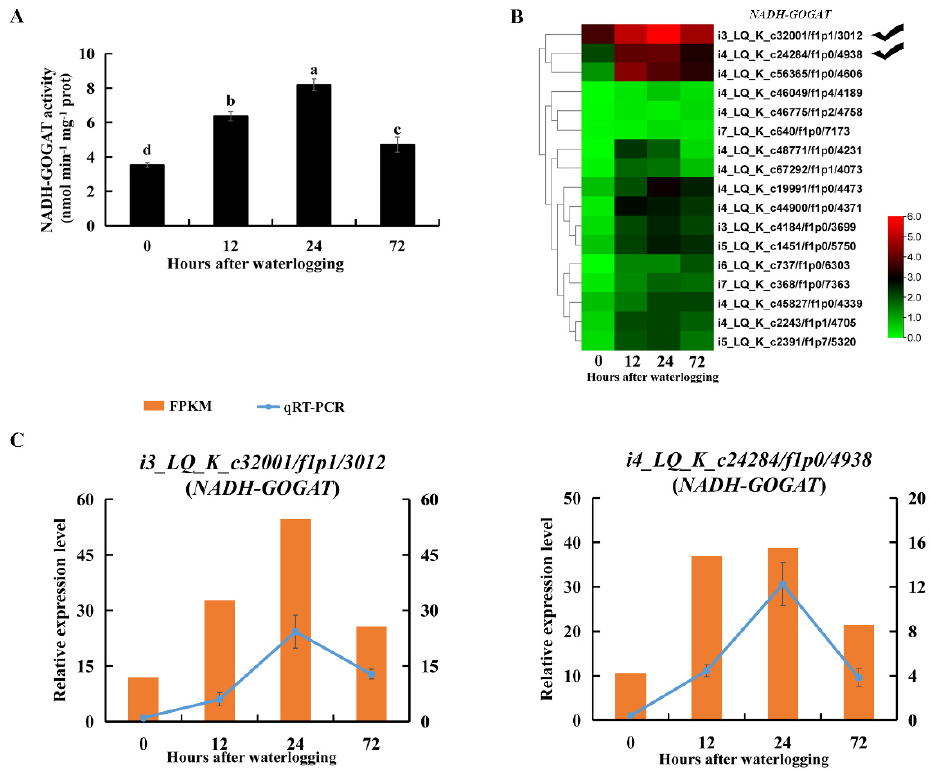
Figure 9. Changes in transcript level and enzyme activity of NADH-GOGAT in KR5 roots under waterlogging stress. ( A ) changes of the activity of NADH-GOGAT; ( B ) transcript changes of NADH- GOGATs ; ( C ) RNA-Seq (right vertical axis) and qRT-PCR (left vertical axis) results for transcript changes in two NADH-GOGATs which were highly induced under waterlogging stress. In ( A ) data are expressed as averages ± SD, n = 3 and significant differences between treatments at p < 0.05 are indicated by different letters over columns (Duncan’s test).